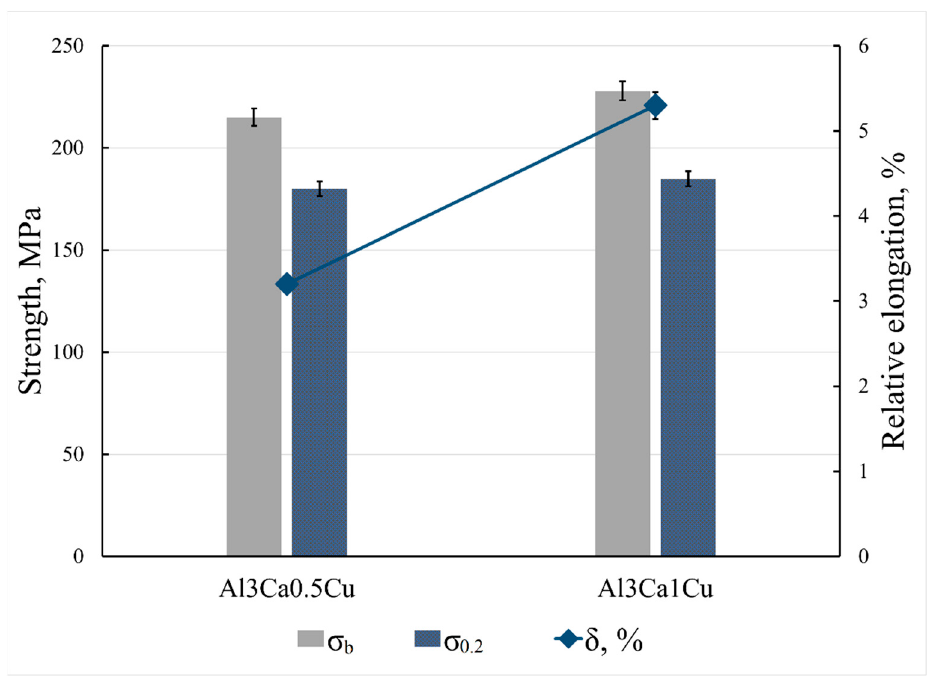
Figure 12. Mechanical properties of the Al3Ca0.5Cu and Al3Ca1Cu sheet alloys.